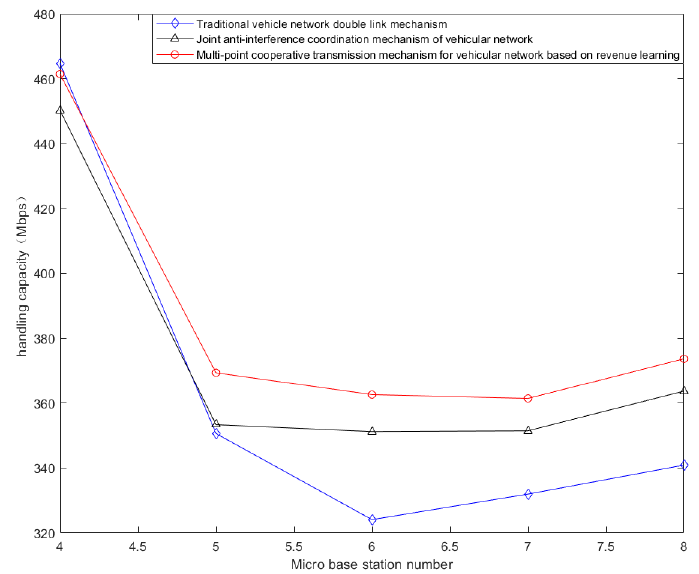
Figure 6. Comparison of cell average throughput under different strategies.